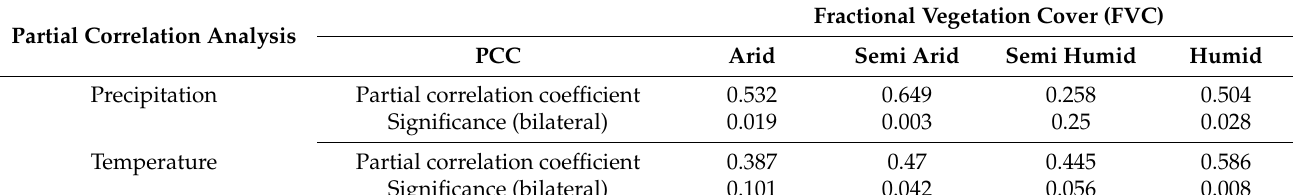
Figure 9. ( a ) The trends of FVC and precipitation changes in 20 years. ( b ) The trends of FVC and temperature changes in 20 years. ( c ) The correlation of precipitation and temperature with FVC in different climate regions. (The AP is the abbreviation of annual precipitation. ATP is the abbreviation of annual average temperature). Table 1. The partial correlation of precipitation and temperature with FVC.